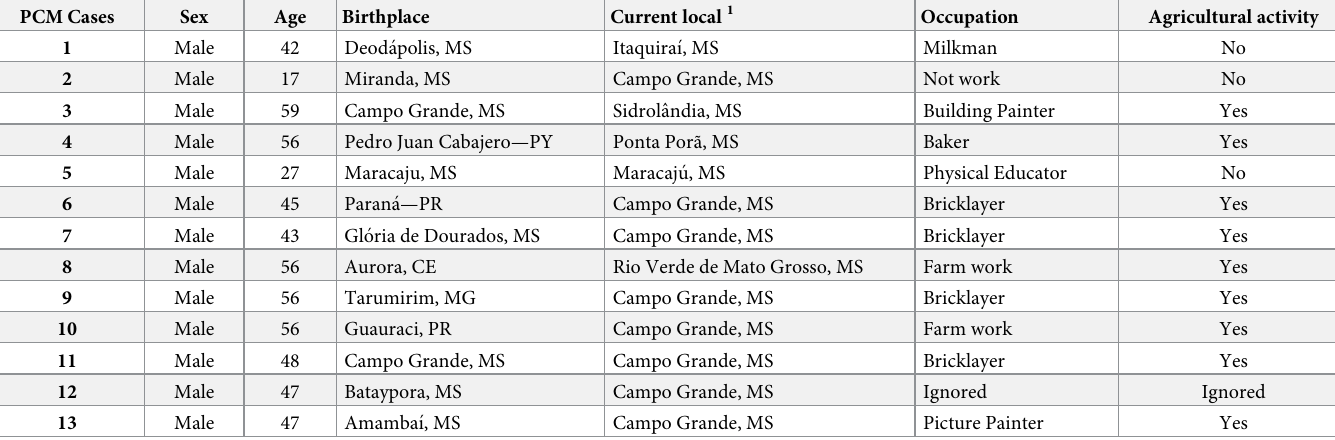
Table 1. Sociodemographic characterization of the studied PCM cases, Mato Grosso do Sul, Brazil (2016–2019). PCM Cases